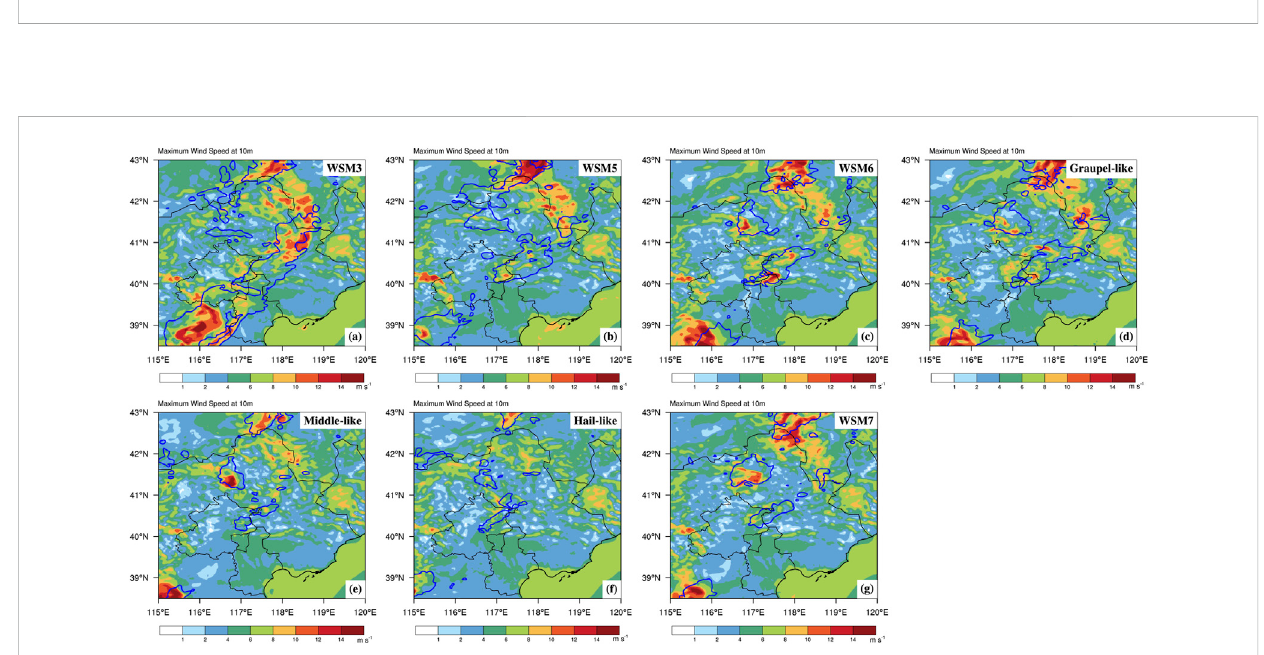
FIGURE 6 Simulated composite radar re fl ectivity (shaded; dBZ) at time of convective development for all seven experiments: (A) WSM3, (B) WSM5, (C) WSM6, (D) WSM6-Graupel-Like, (E) WSM6-Middle-Like, (F) WSM6-Hail-Like and (G) WSM7 experiments.Theblacklinescorrespondtothepositionsofthecross section for each experiment shown in Figures 14, 15. In Figure 6A, the grey solid box contains the area used to calculate the graupel particles characteristics in Figures 11, 12, and the grey dashed box indicates the region used to calculate environmental conditions for surface buoyancy. The speci fi c times of convective development for each experiment are shown in Table 2.